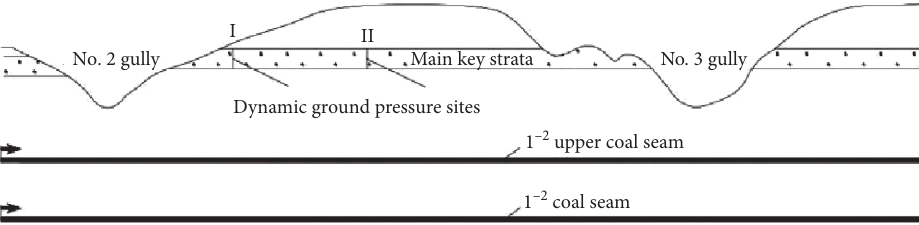
Figure 3: Site of dynamic strata